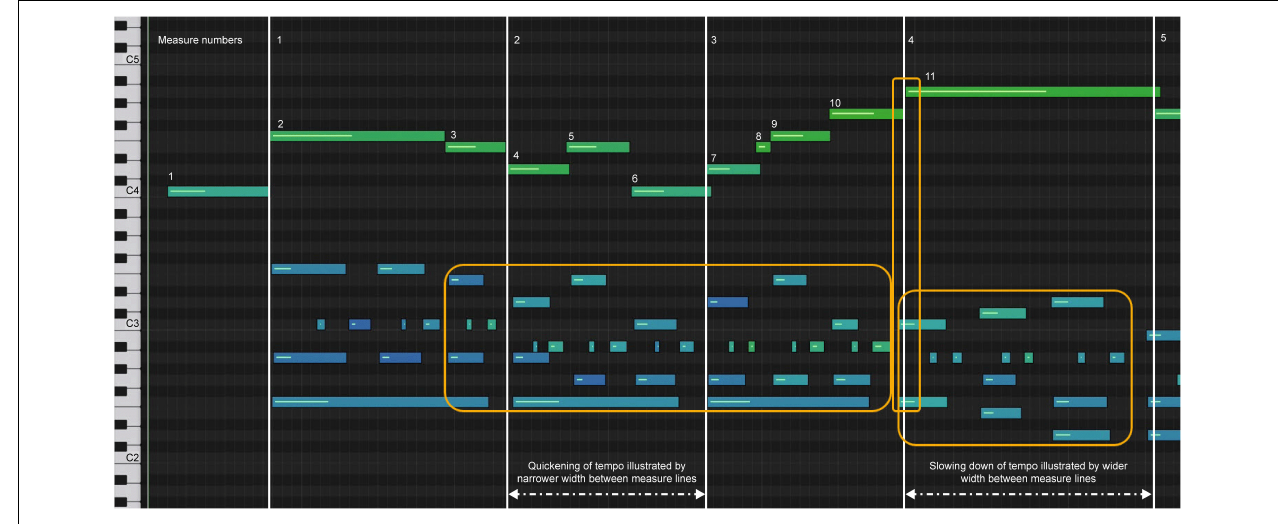
FIGURE 4 | Sonification score, model A, measures 1–4.